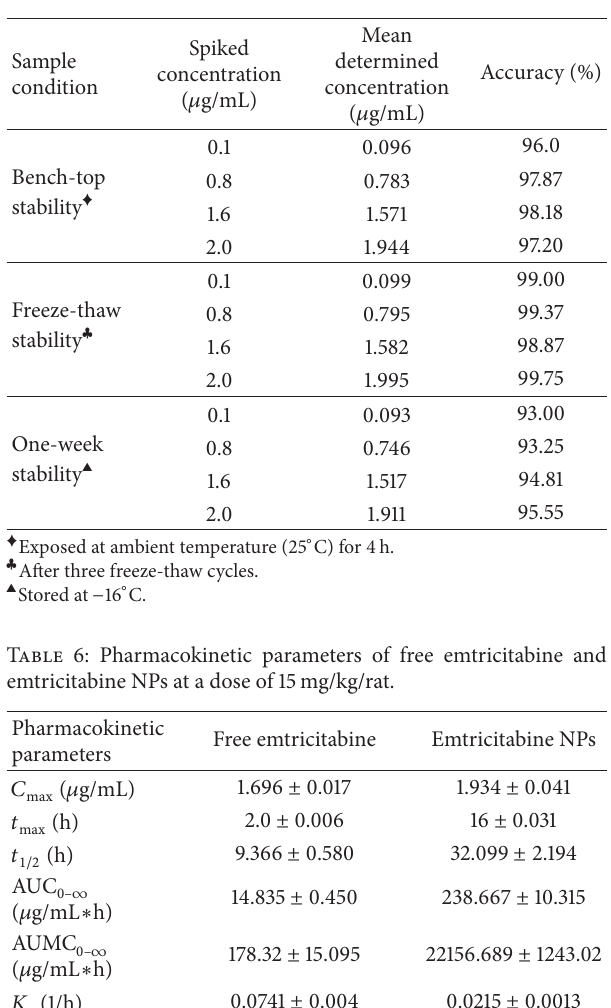
Table 5: Stability of emtricitabinein rat plasma ( n = 6).